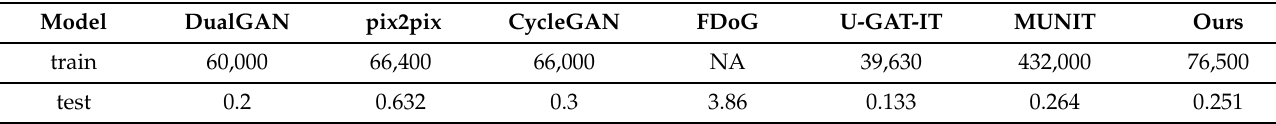
Figure 13. Our illustrative sketch portraits compared with APDrawingGAN [9], one of the state-of-the-art works. Table 3. Comparison of computation time for training and test. Train time is recorded as seconds for all training epochs and test time as the seconds taken to process one image. Note that the train time for FDoG is Not Available, since it is not a deep-learning-based method.